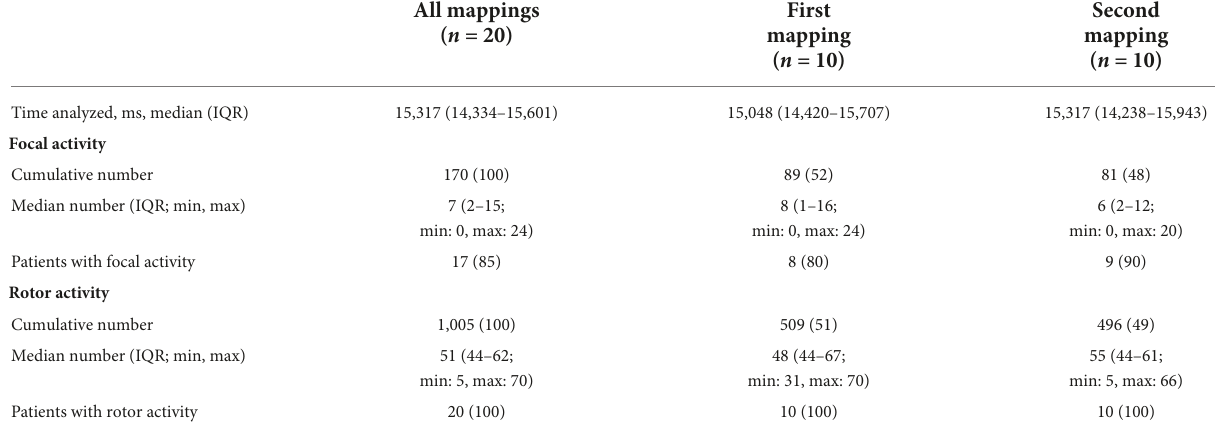
TABLE 2 Overall number of